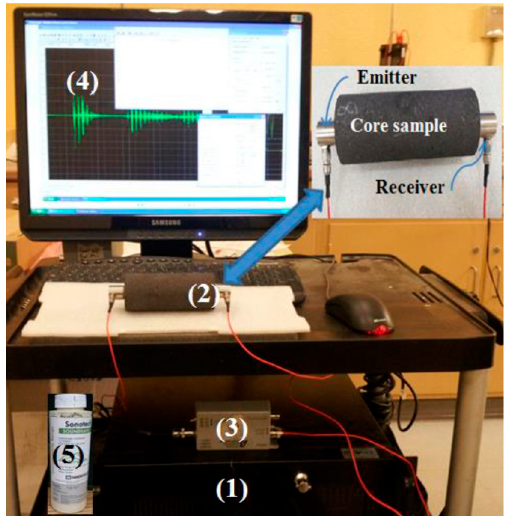
Figure 1. The acoustic inspection system. (1) Multi ‐ channel acoustic emission system, (2)